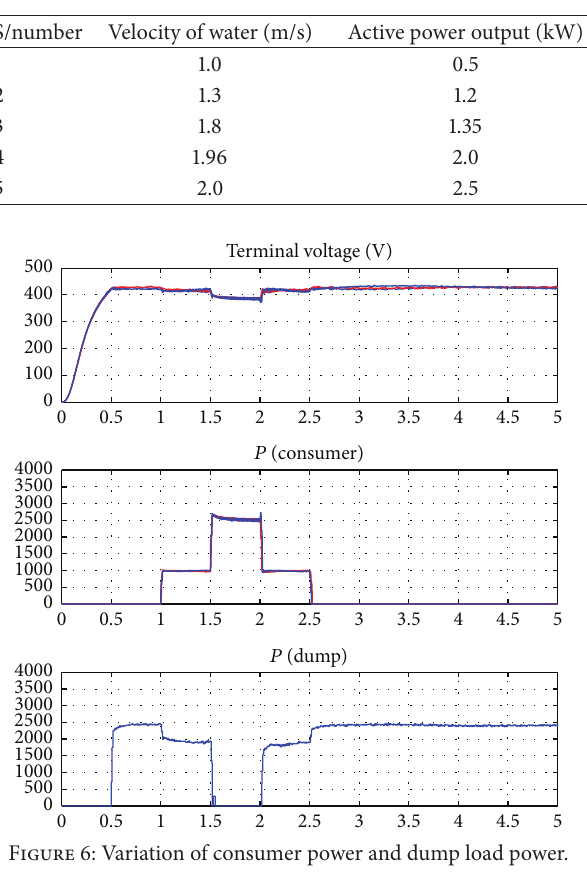
Figure 6: Variation of consumer power and dump load power.